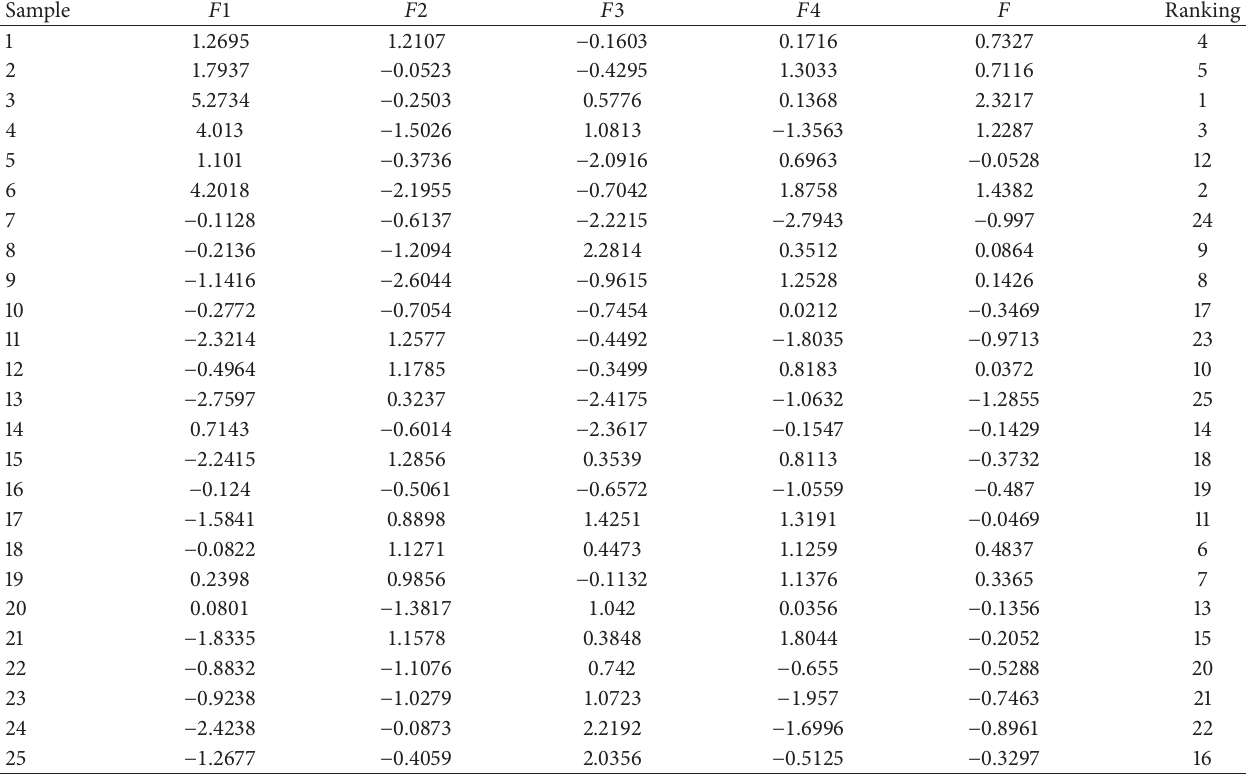
Table 9: Eigenvalues of samples in 1, 2, 3, and 4 principal